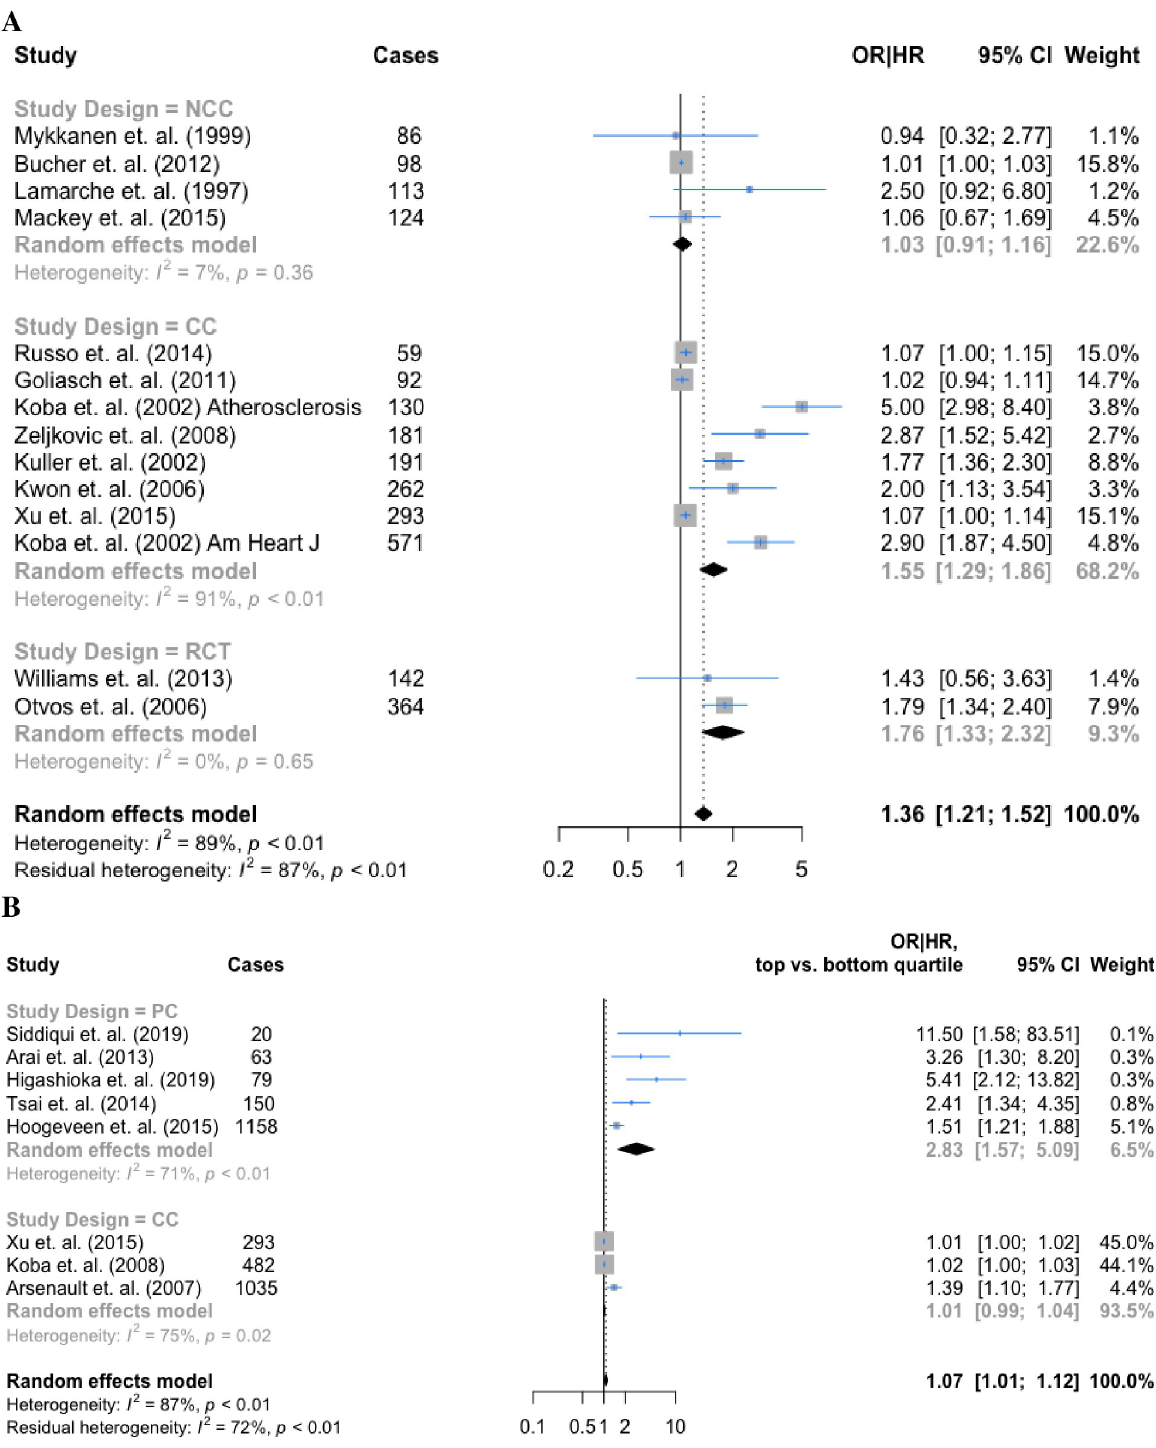
Fig 3. Forest plots of association between (A) sdLDL, (B) sdLDL-C and CHD subgrouped by study design. PC = prospective cohort study; CC = case-control study; NCC = nested case-control study; RCT = randomized controlled trial.